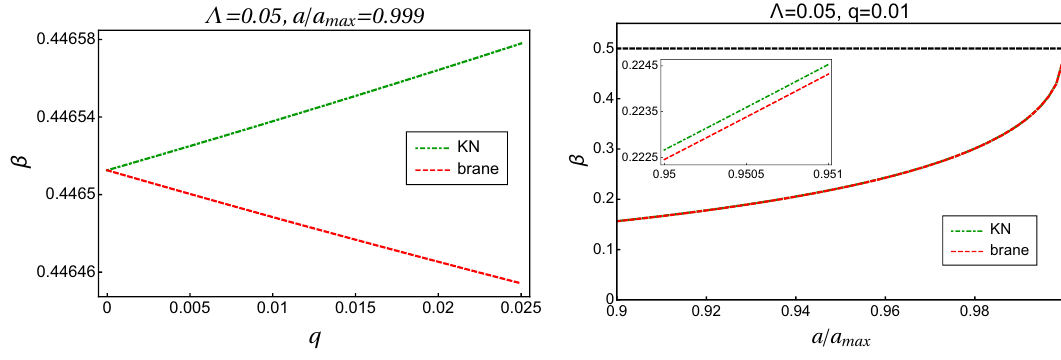
Figure 7 . A comparison between four dimensional Kerr-Newman-de Sitter black hole and the Kerr-de Sitter black hole in e(cid:11)ective gravitational theory on the brane has been presented. On the left panel, the variation of the parameter (cid:12) against the \charge" in the respective contexts has been plotted with a (cid:12)xed cosmological constant (cid:3) and normalized rotation parameter ( a=a max ). While the plot on the right depicts variation of (cid:12) with ( a=a max ) for a (cid:12)xed \charge" and cosmological constant. As evident both of these plots indicate that the parameter (cid:12) is always smaller for the rotating black hole spacetime in the four dimensional brane compared to the four dimensional Kerr-Newman-de Sitter